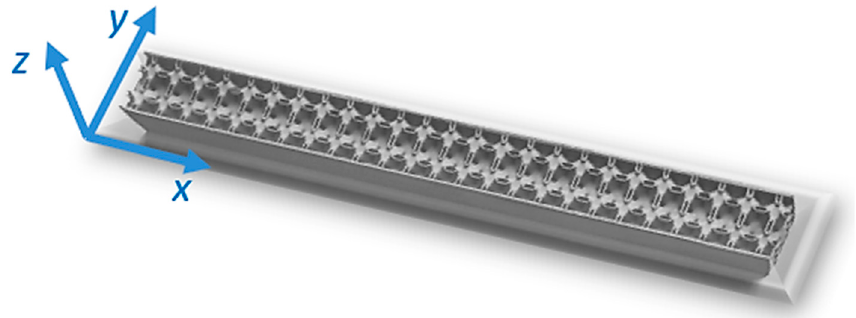
Figure 3. Orientation of the sample in the workspace of the 3D printer.